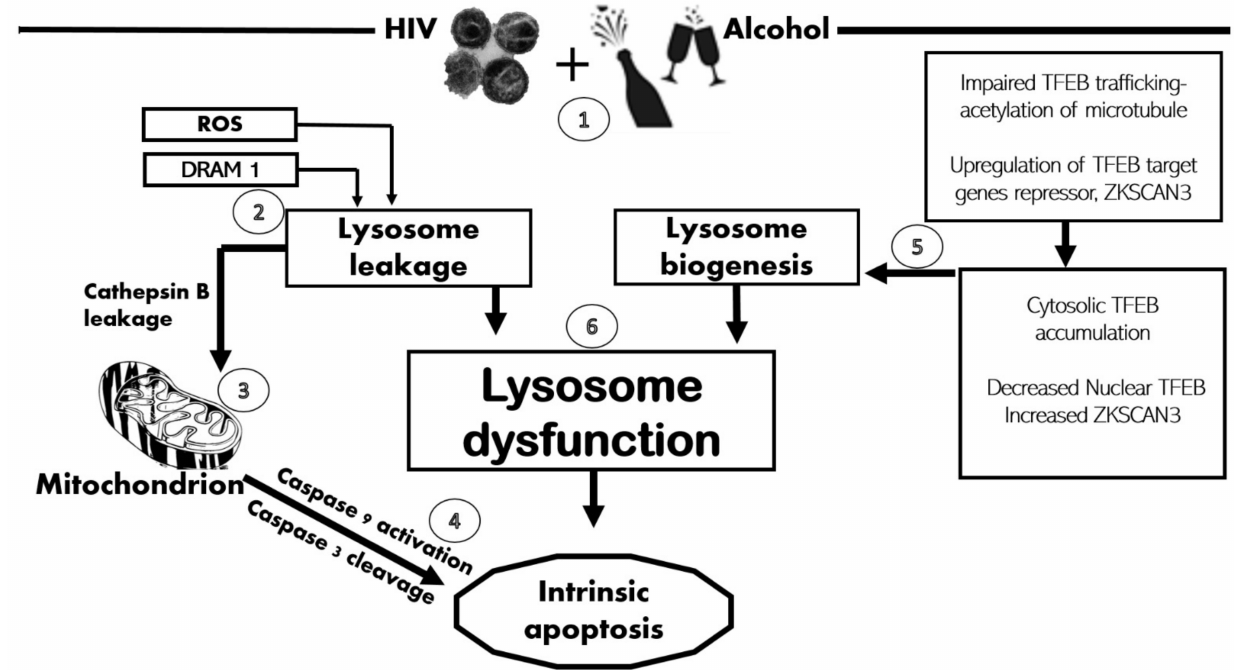
Figure 7. Role of lysosomal rupture/dysfunction in HIV- and ethanol-metabolism-induced apoptosis in hepatocytes: (1) Combined treatment with HIV and AGS triggers ROS and acetaldehyde release, which mediates lysosome leakage; (2) HIV/ethanol metabolism triggers the release of DRAM1, which also induces lysosome leakage; (3) Cathepsin B leaked out from damaged lysosome and diffused into the mitochondrion to initiate the intrinsic apoptotic pathway; (4) Caspases 9 and 3 become cleaved, leading to hepatocyte apoptosis; (5) Alcohol metabolites inhibit lysosome biogenesis factor TFEB, hence impairing the compensation of damaged lysosomes; and (6) Both lysosome damage and impaired lysosome biogenesis lead to HIV–ethanol-metabolism-induced lysosome dysfunction, which triggers